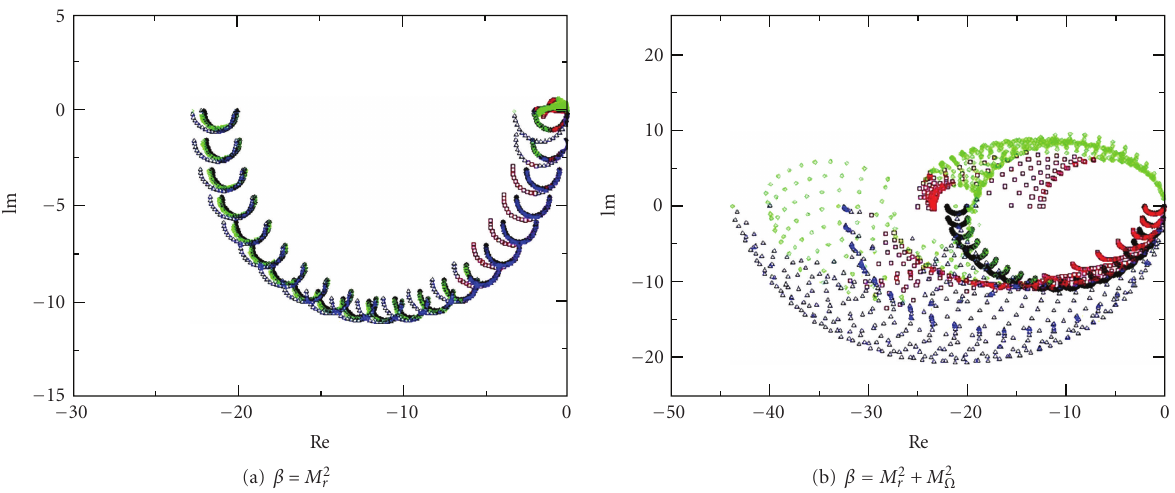
Figure 2: Fourier footprint of Euler operator for rotating flow ( M r = 0 . 01, M Ω = 0 .